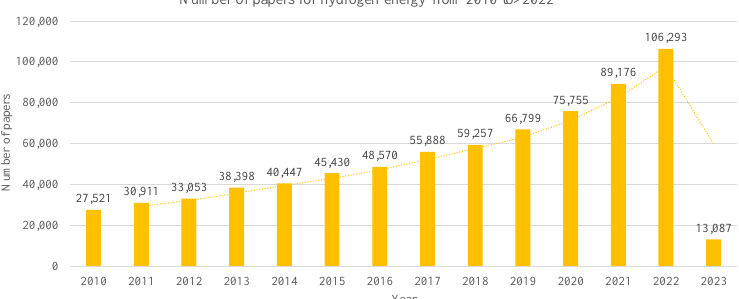
Figure 11. Development of research in the field of hydrogen energy (2010–2022). The dotted line represents the moving average of the published